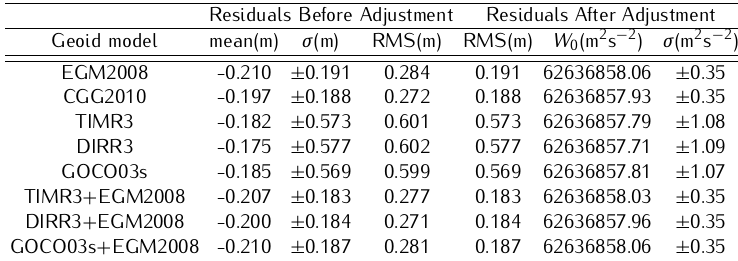
Table 3. Statistics of the residuals before and after the adjustment for 5 geoid models (m), their corresponding W (m 2 s − 2 ). The results are based on the DTU10 SST and the GPS